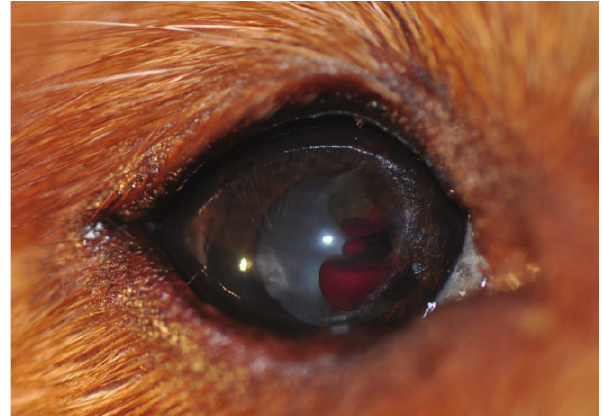
Figure 1: Photograph of the right eye with multiple uveal hemato- cysts. Iris hyperpigmentation, pigment deposits on the anterior lens capsule, medial posterior synechia, and an incipient cataract are also present. Upper and lower distichia are an incidental